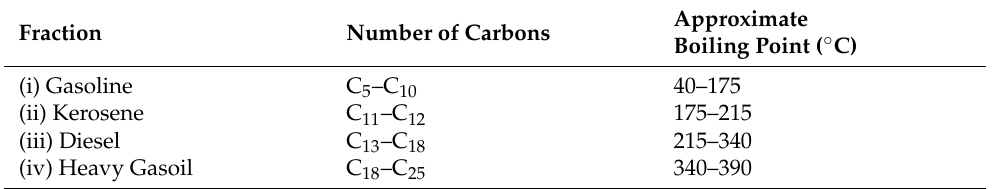
Table 3. Approximate boiling ranges of different hydrocarbon fractions.